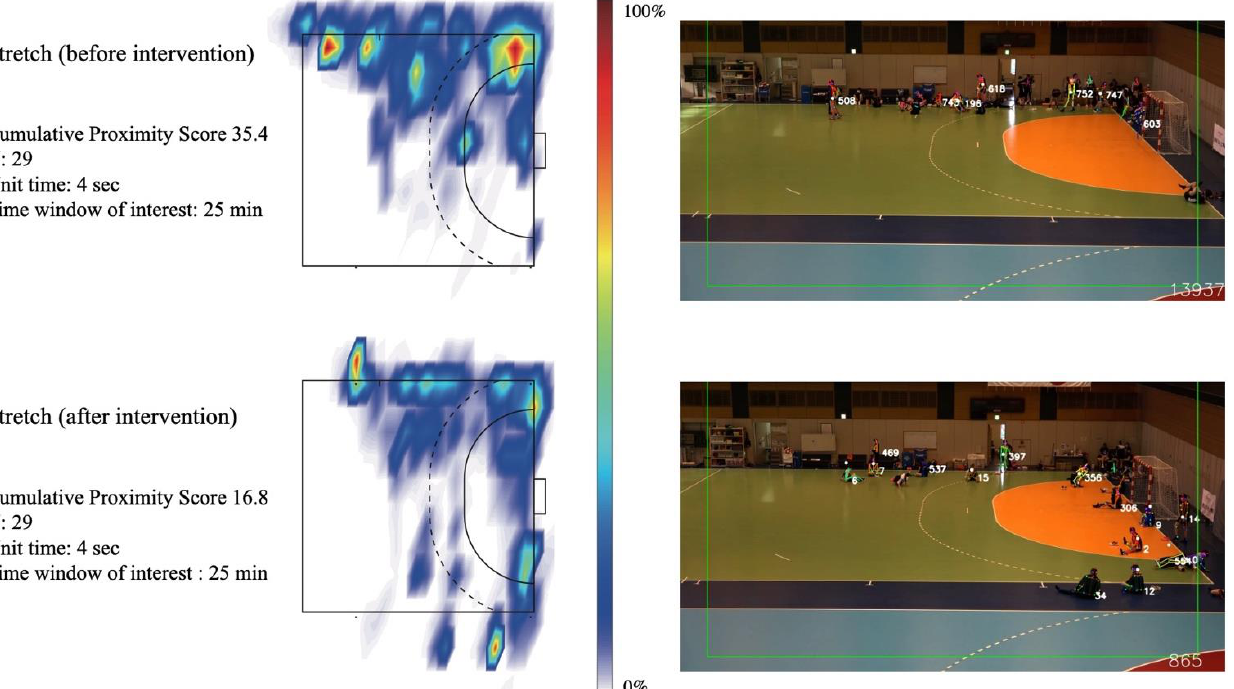
Figure 6. Transition of high-proximity distribution during stretching, before and after intervention. The color map represents a 0 to 100% scaled value where no proximity IDs observed (0%, white) to where the most frequently proximity IDs observed (100%, dark red) during the time window of interest.